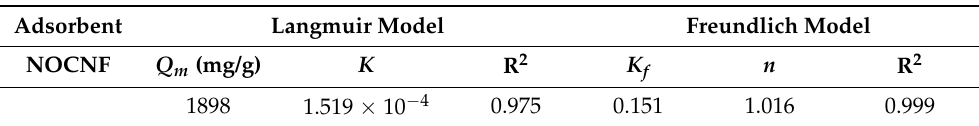
Figure 9. ( a ) Langmuir and ( b ) Freundlich isotherm fitting of the Tl(I) adsorption isotherm data by NOCNF (0.32 wt%). Table 2. Summary of parameters using Langmuir and Freundlich models to fit the Tl(I) adsorption isotherm data.